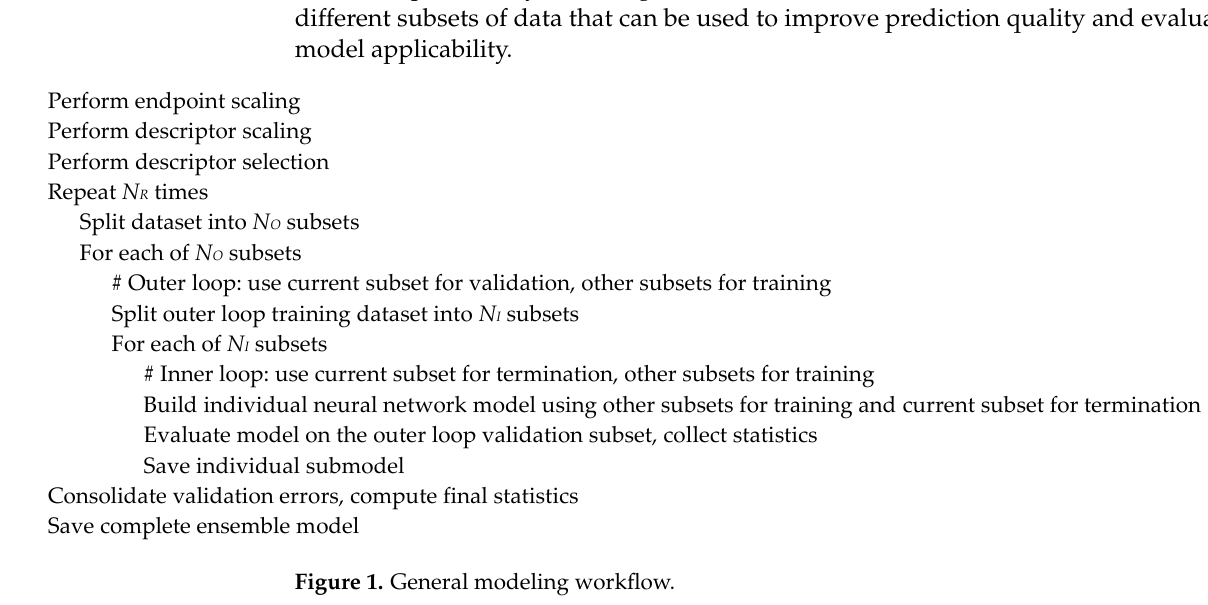
Figure 1. General modeling workflow.